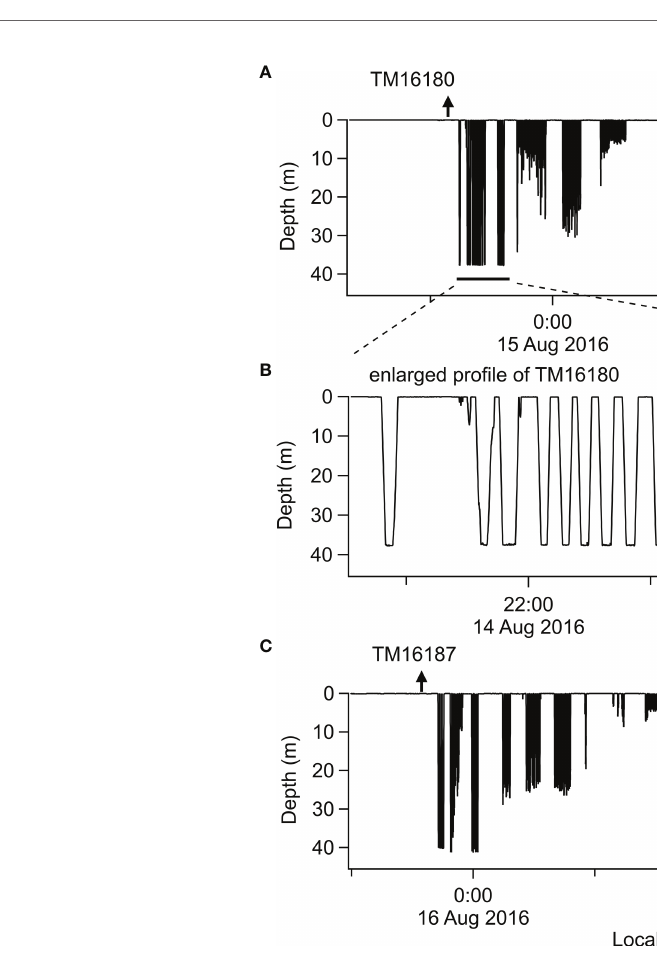
FIGURE 5 | Time-depth records collected from two thick-billed murres U. lomvia (TM16180 and TM16187) (A, C) surveyed from Tuqaghuk colony during the chick- rearing stage in 2016. The arrows indicate trip departure (up arrow) and return (down arrow) based on acceleration and temperature. The middle panel (B) is detailed pro fi les of dives reaching to constant depth (37.6 – 37.8 m), showing characteristic benthic diving